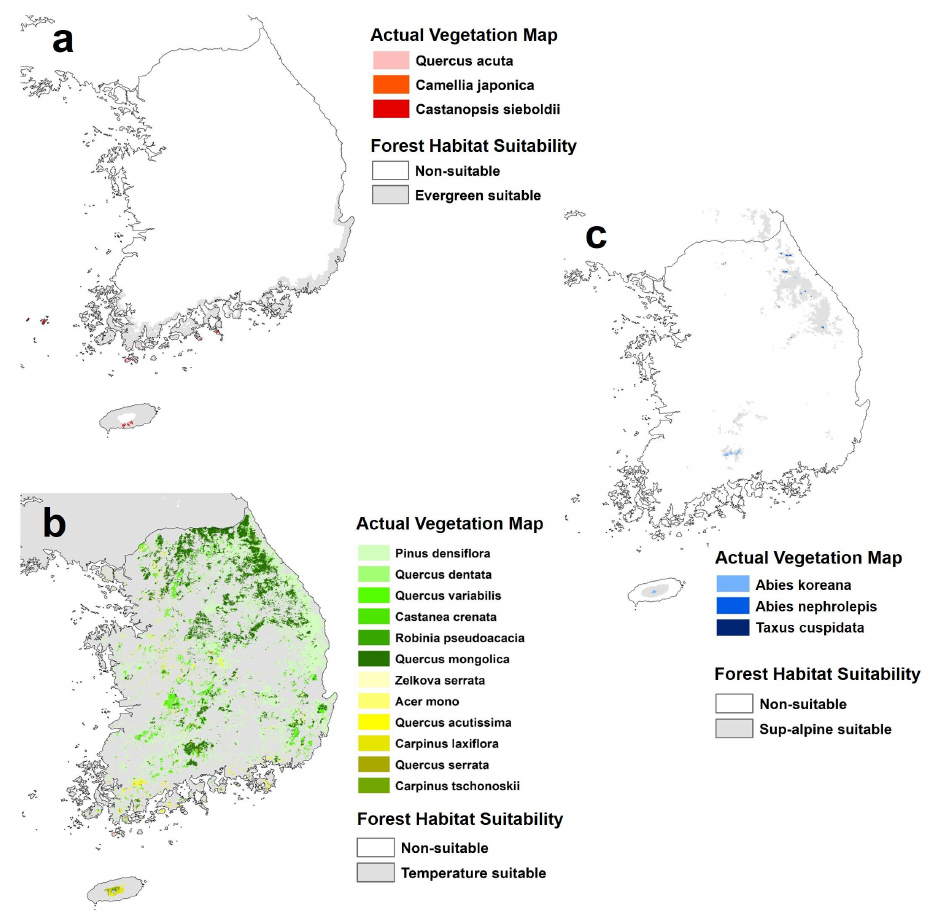
Figure 5. Comparison with actual vegetation maps for evaluation of habitat modeling performance (( a ): warm temperate evergreen forest; ( b ): temperate forest; ( c ): subalpine